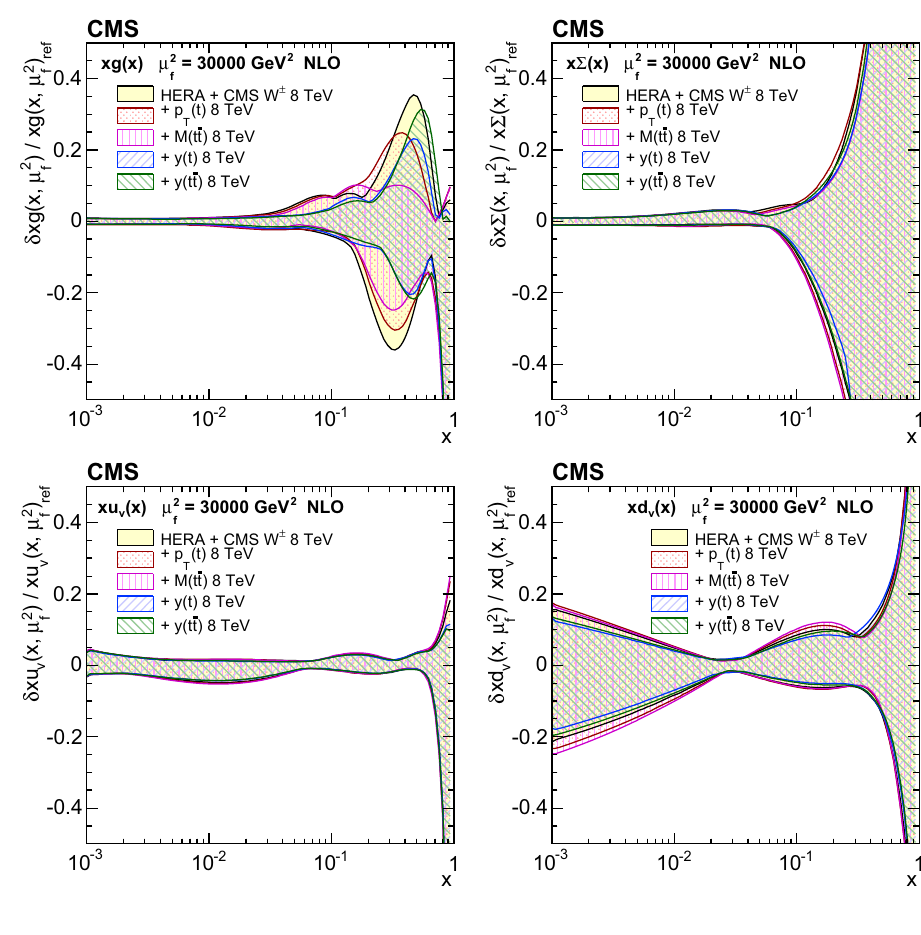
Fig. 17 The same as in Fig. 15 for the variants of the PDF fit using the single-differential tt cross sections